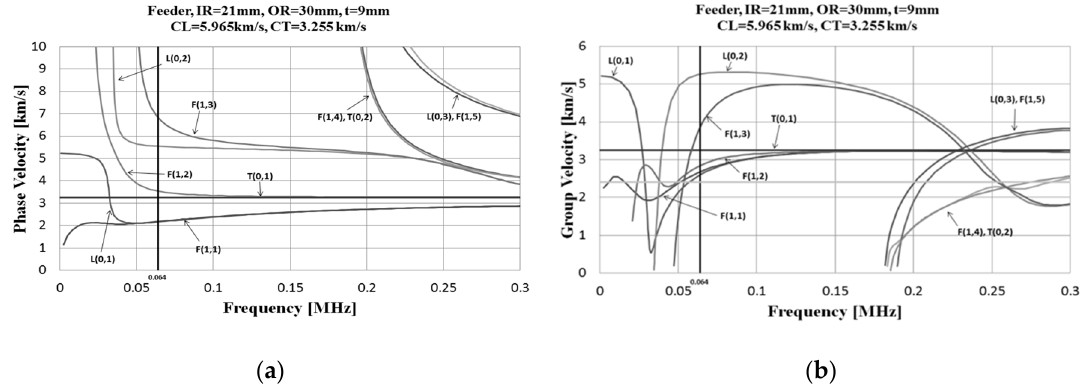
Figure 1. Curves of the ( a ) phase velocity and ( b ) group velocity of a carbon steel pipe with inner radius of 21 mm and outer radius of 30 mm.